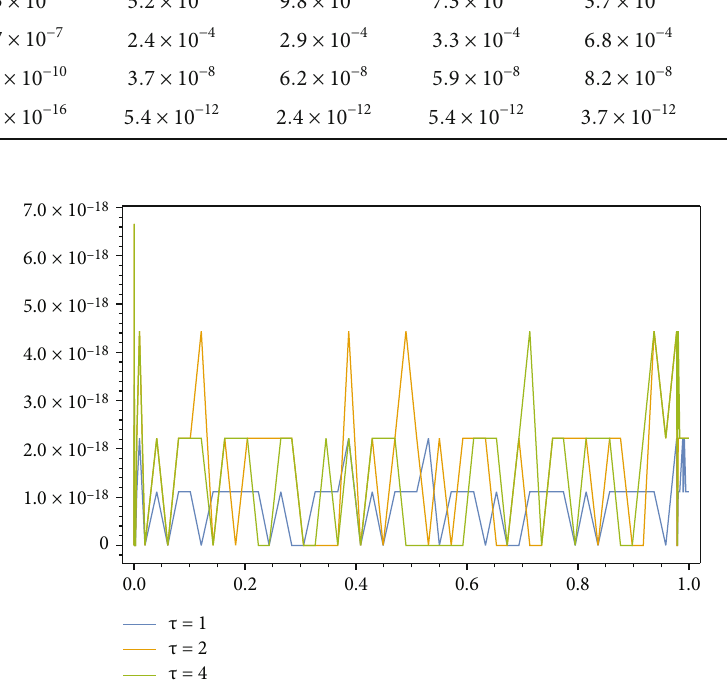
Figure 2: Absolute errors of example 4 — γ = 2, N = 16